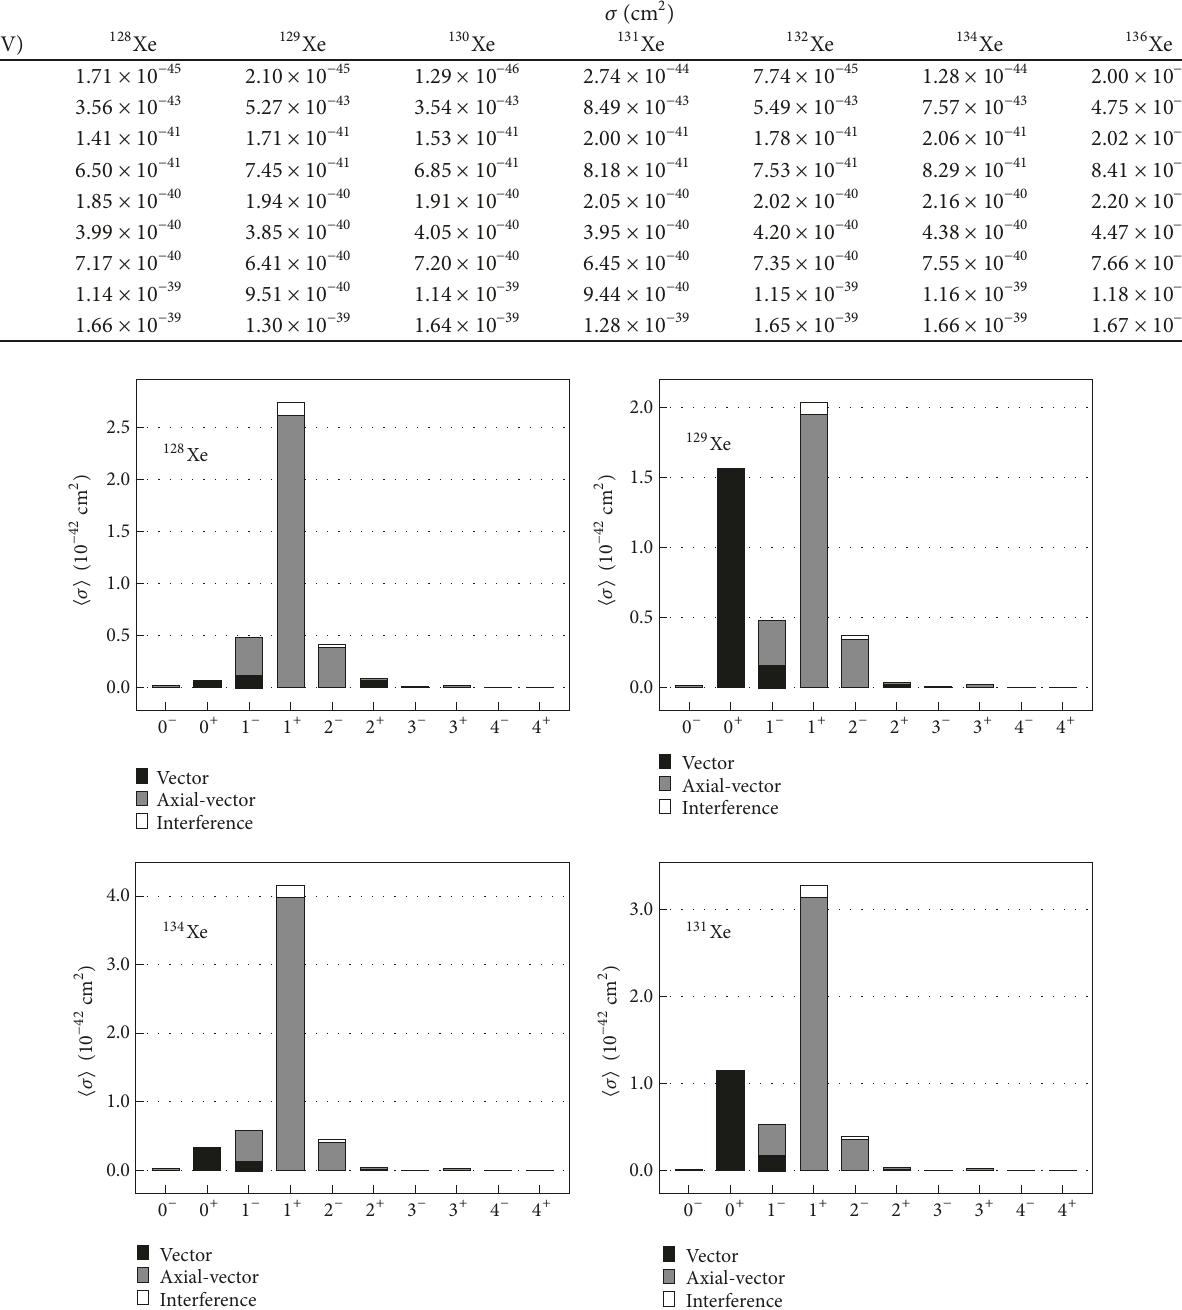
Table 5: Inelastic neutral-current scattering cross section for neutrinos scattering off xenon targets as a function of neutrino energy. The cross sections are given in units of cm 2 . The computations were made in the QRPA/MQPM formalism.